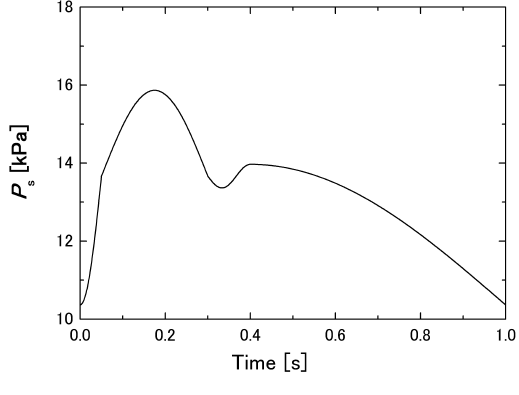
Fig. 5 Waveform of supply pressure P s